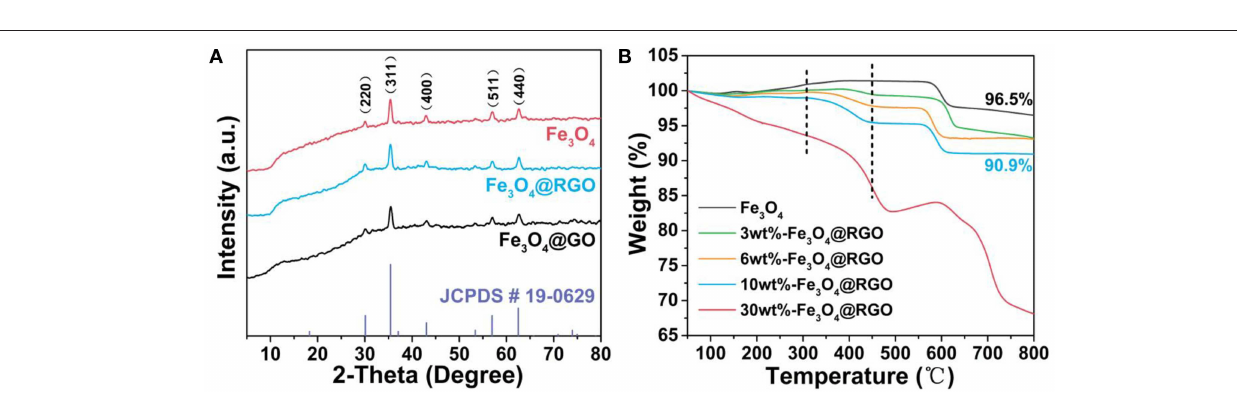
Fe 3 O 4 @GO, Fe 3 O 4 @RGO and RGO. The D and G peaks of graphene are clearly observed in all curves. The peaks at about 660 cm − 1 of Fe 3 O 4 @GO and Fe 3 O 4 @RGO can be attributed to the A 1g mode of Fe 3 O 4 (Sun et al., 2009). The appearance